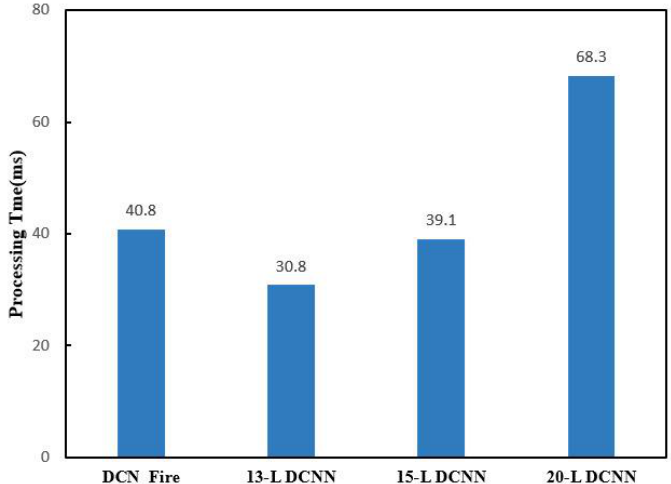
Figure 5. Flame image processing time comparison of the DCN_Fire model and 13-layer, 15-layer, and 20-layer DCNN models.